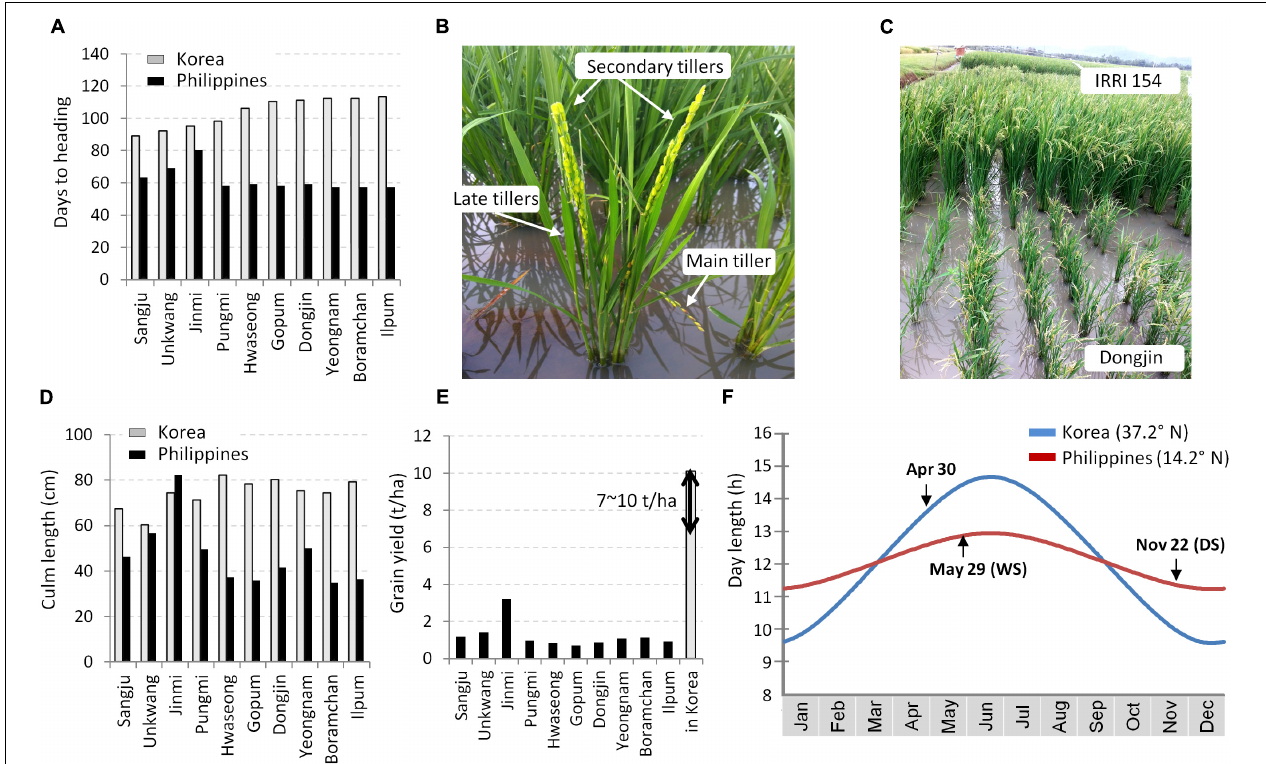
FIGURE 1 | Phenotypes of the temperate japonica varieties in the tropical region. Ten Korean temperate japonica varieties were tested in the dry season in Los Baños (14.2 ◦ N), Philippines and in Suwon (37.2 ◦ N), Korea. (A) Comparison of days to heading (DTH). (B) Irregular flowering among tillers (Dongjin variety). (C) Photo of the maturation stage. (D) Comparison of culm length. (E) Comparison of grain yield. Yield data in Korea were obtained from the rice variety information released by the RDA. (F) Seasonal day-length (h) of the RDA Suwon station and the IRRI headquarter in Los Baños. The dates of seeding are depicted in the graph. DS, dry season; WS, wet